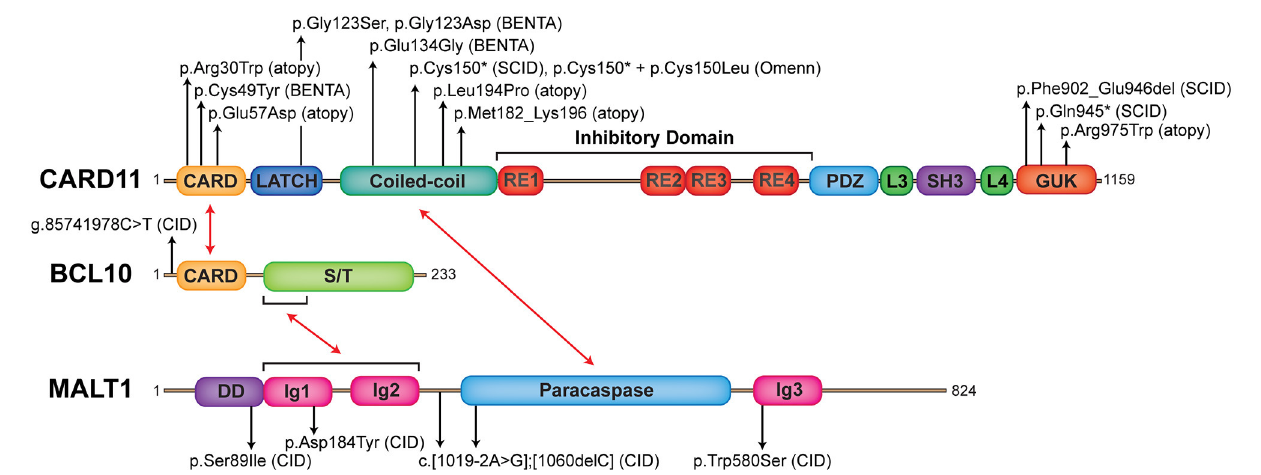
FIGURE 1 | The landscape of human germline mutations causing CBM-opathies. Schematic representation of protein domains found in CARD11, BCL10, and MALT1. Red arrows indicate interactions between domains. Annotated are confirmed mutations causing CBM-opathies and where they localize to on the protein. CARD, caspase recruitment domain; RE, repressive element; L, linker; PDZ, postsynaptic density protein (PSD95), Drosophila disc large tumor suppressor (Dlg1), z onula occludens-1 protein (zo-1) domain; SH3, SRC homology 3 (SH3); GUK, guanylate kinase domain; S/T, serine/threonine; DD, death domain; Ig, immunoglobulin-like domain.